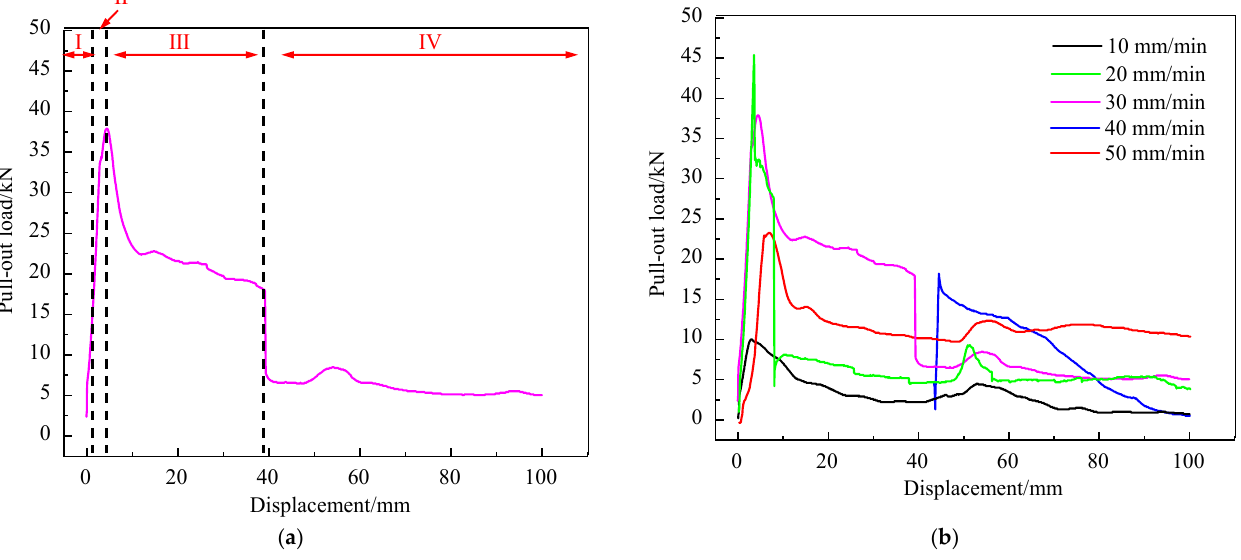
Figure 6. Relationship between pull-out load and pull-out displacement: ( a ) the four stages; ( b ) relationship between pull-out load and pull-out displacement at different pull-out rates.